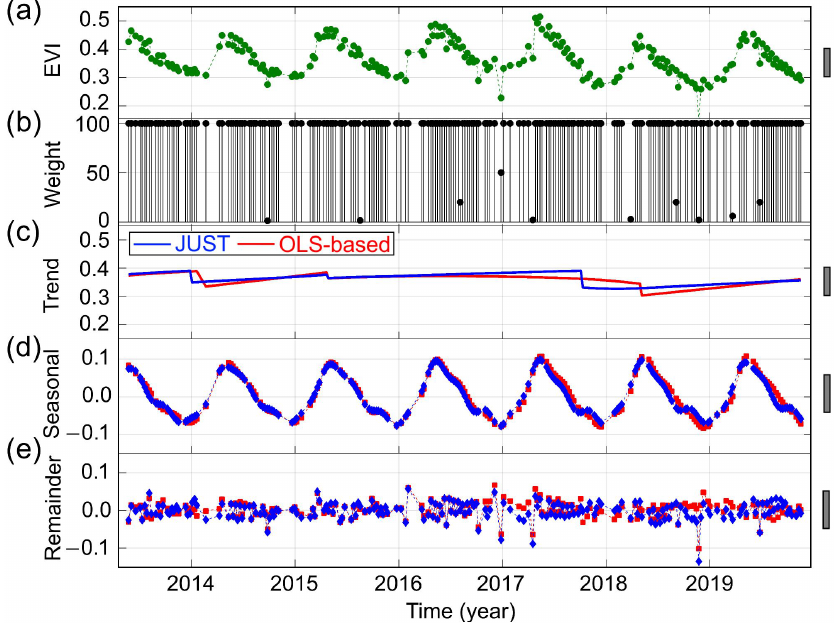
Figure 15. Decomposition results of the EVI time series corresponding to pixel B shown in Figure 13c, see the caption of Figure 14 for more